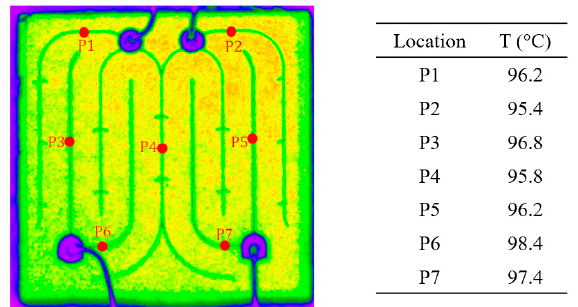
Figure 7. The surface temperatures of a blue LED were measured at different locations with the thermoreflectance method. Reprinted with permission from Ref. [145]. Copyright 2018, American Physical Society.